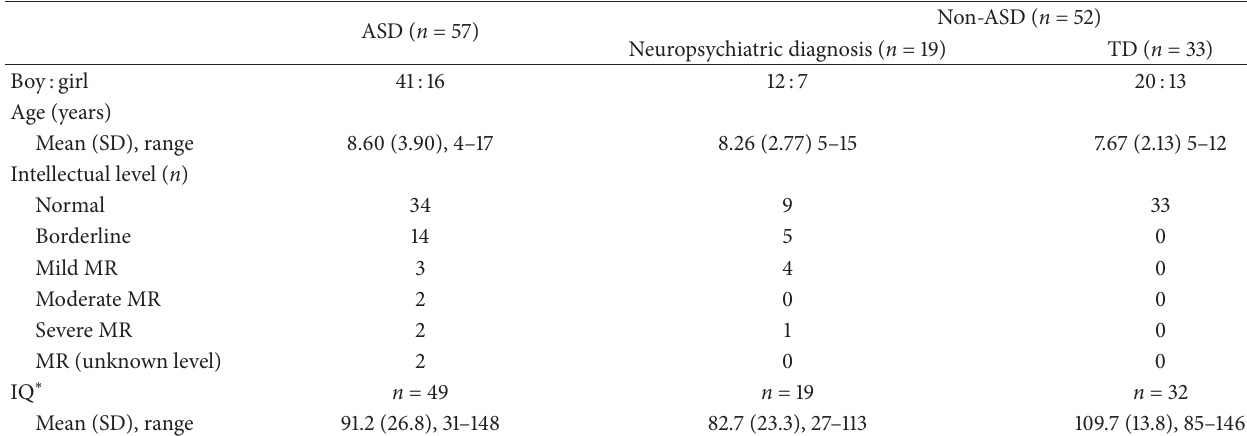
Table 2: Demographic characteristics of 109 children rated by both teacher and